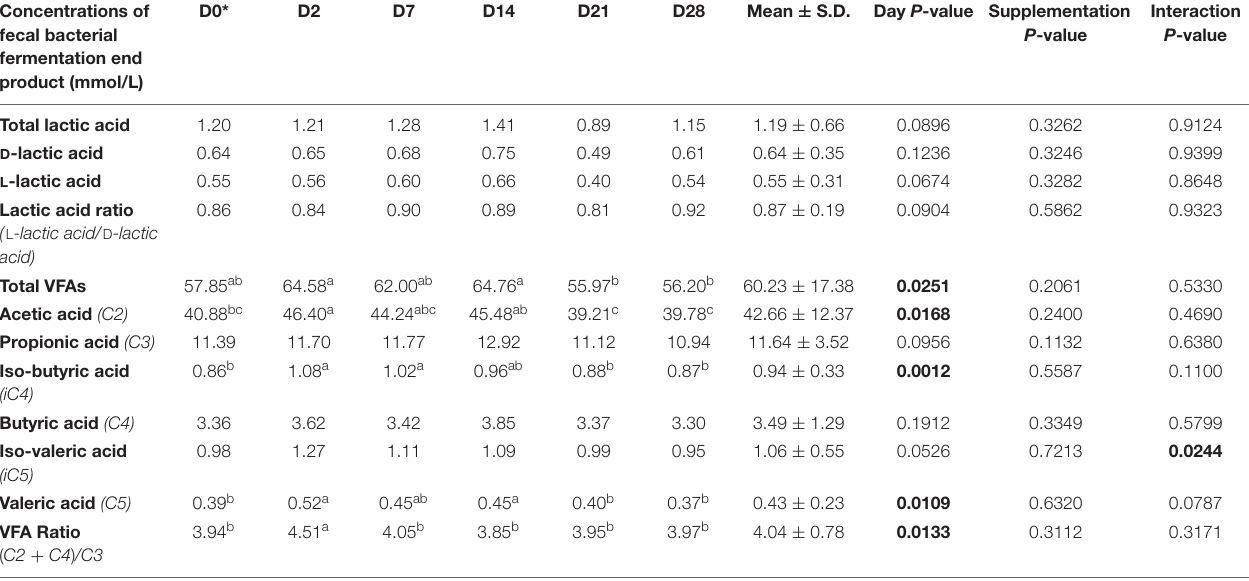
FIGURE 3 | Variations in the bacterial functional group concentrations according to the day in fecal samples of horses subjected to TMS oral challenge from D0 to D4. For each group, mean concentrations with different superscripts differ at P < 0.05. ∗ D0: Basal value before the first TMS administration. TABLE 3 | Variations in bacterial fermentation end-product concentrations (mmol/L) and ratios reported in fecal samples of horses subjected to an oral challenge with TMS from D0 to D4 by